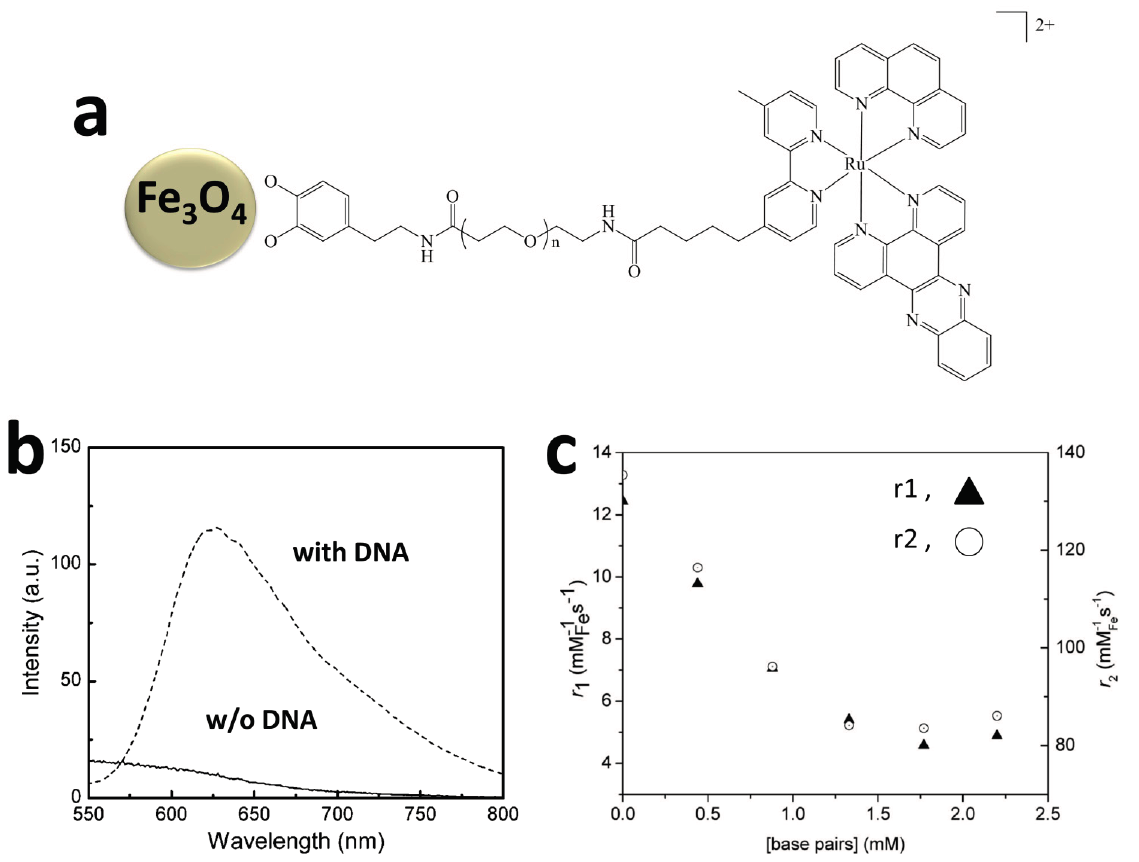
Figure 27. Magnetoluminescent light switch probe for dual mode DNA detection. Reprinted with permission from ref. [306], copyright (2013) American Chemical